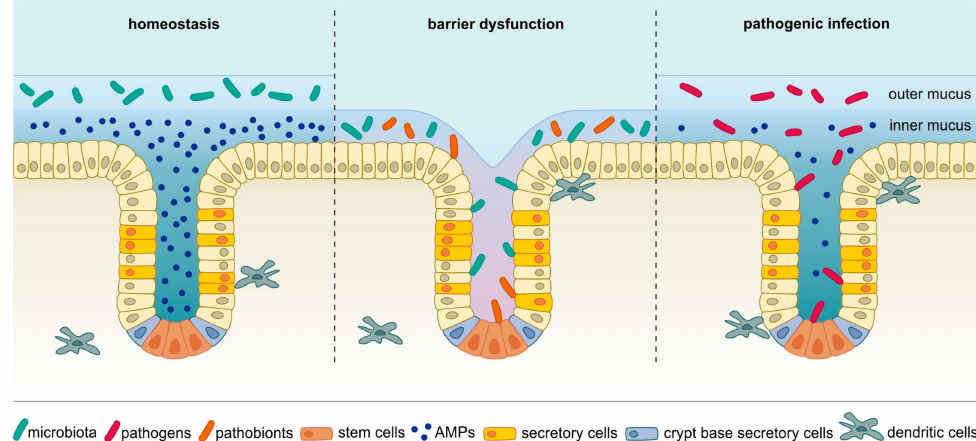
Figure 1. In homeostatic conditions (left), the microbiota resides exclusively in the outer mucus layer. When the barrier is disrupted, for example, through injury, impaired mucus production or chronic inflammation (middle), bacteria, including members of the microbiota and pathobionts, can establish contact with epithelial cells and even invade crypts and interact with stem cells. In addition, distinct pathogens have evolved mechanisms to breach even an intact mucus barrier to make contact with host cells (right). These bacteria can also penetrate glands and adhere to stem cells. AMPs: antimicrobial